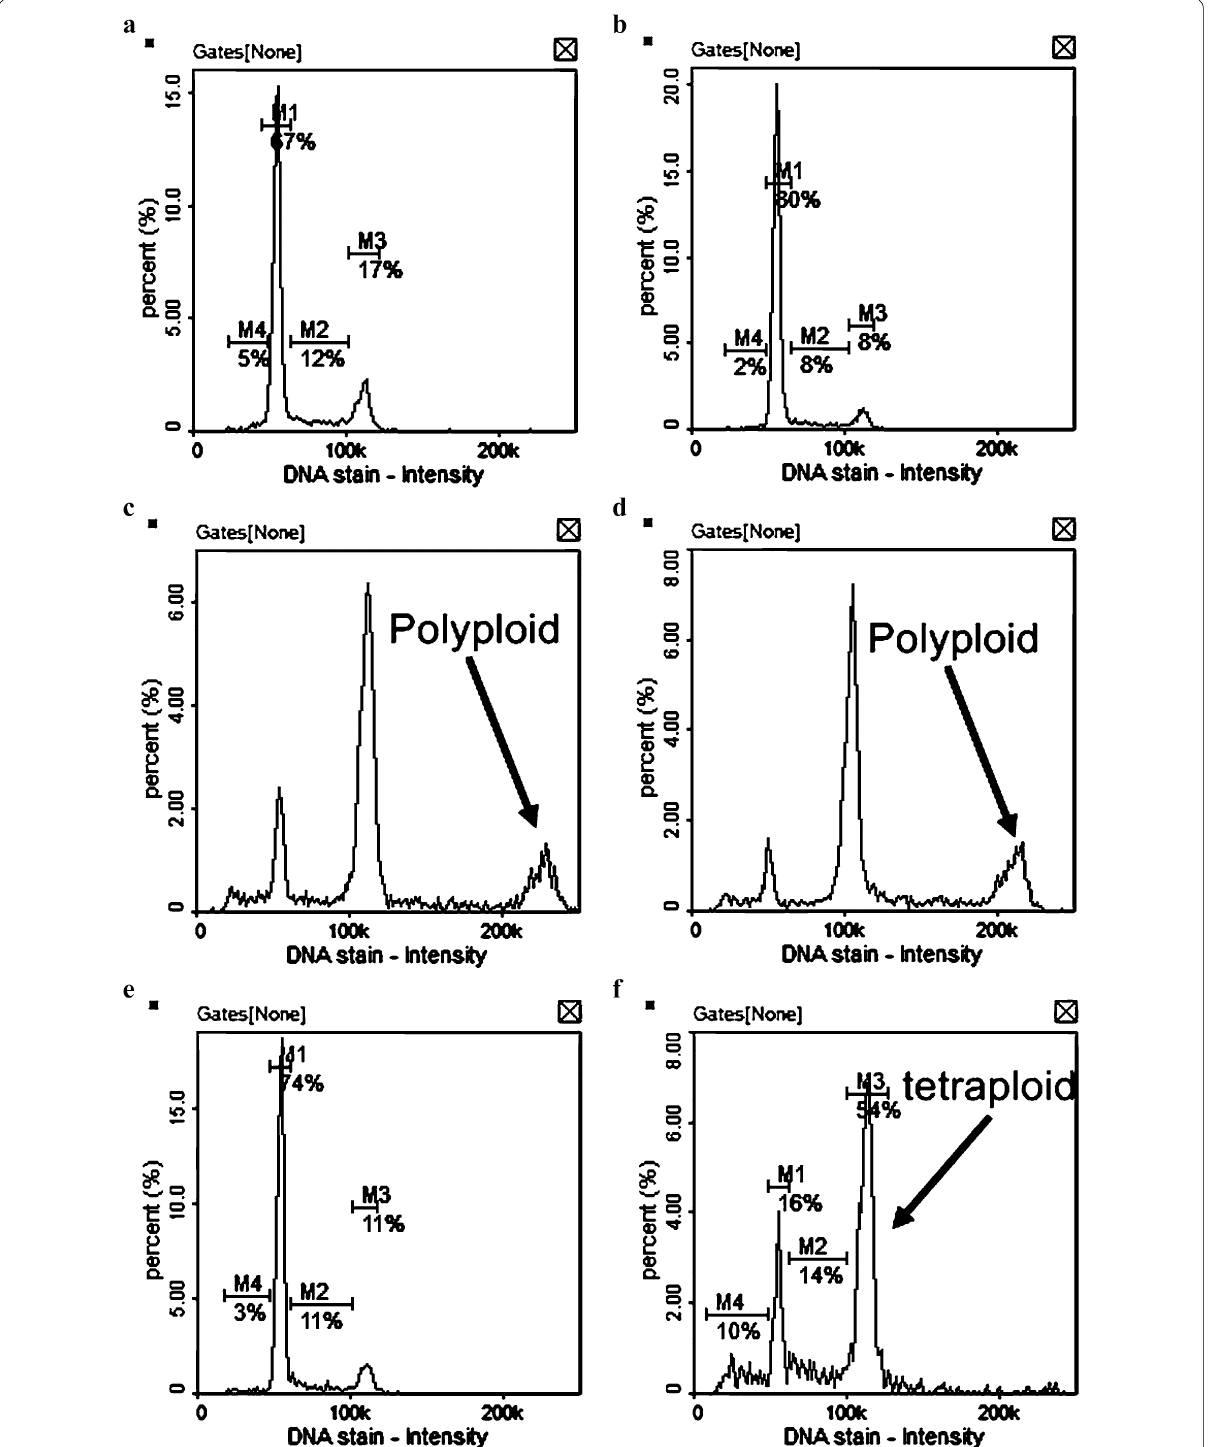
Fig. 3 Cell cycle profiles of HCT‑116 cells treated with a 1% DMSO (control); b sunitinib (5.0 μM); c 7 (5.0 μM); d 13 (3.0 μM); e 14 (3.0 μM); f 15 (3.0 μM) for 24 h. M1 G0/G1phase, M2 S phase, M3 G2/M